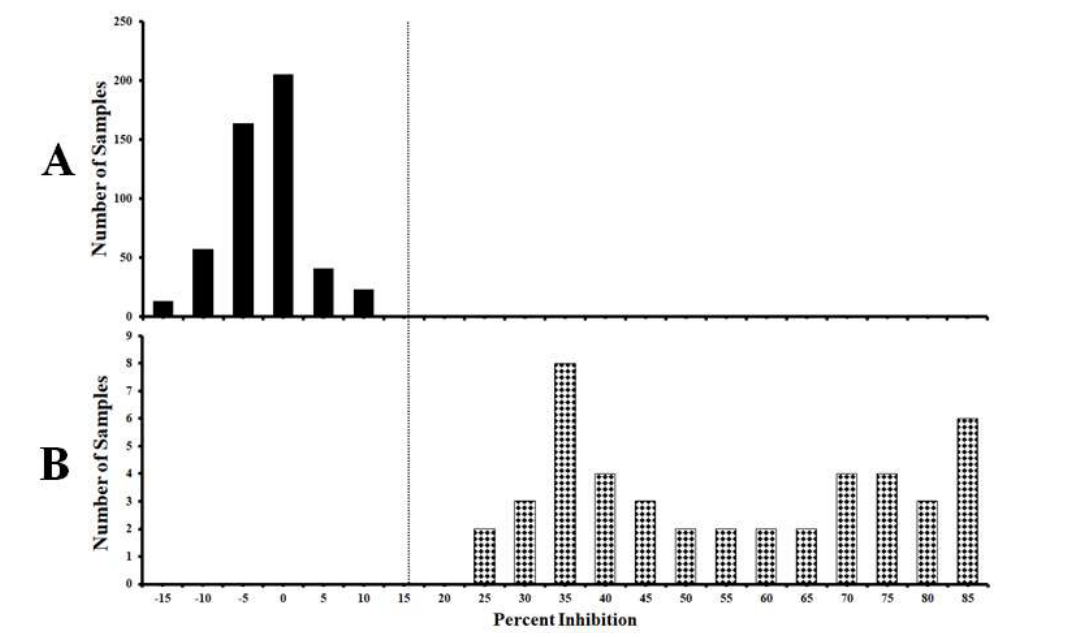
Figure 3. Standardization of the cut-off value of mAb1504-based cELISA. ( A ) Negative serum samples from unvaccinated pigs ( n = 504). ( B ) C-strain antibody positive serum samples from C-strain or C-strain E rns protein immunized pigs (14–56 DPV) ( n = 45). The dotted line represents cut-off value of 15.99% inhibition when using the mean PI of negative sera plus three SD as the threshold.